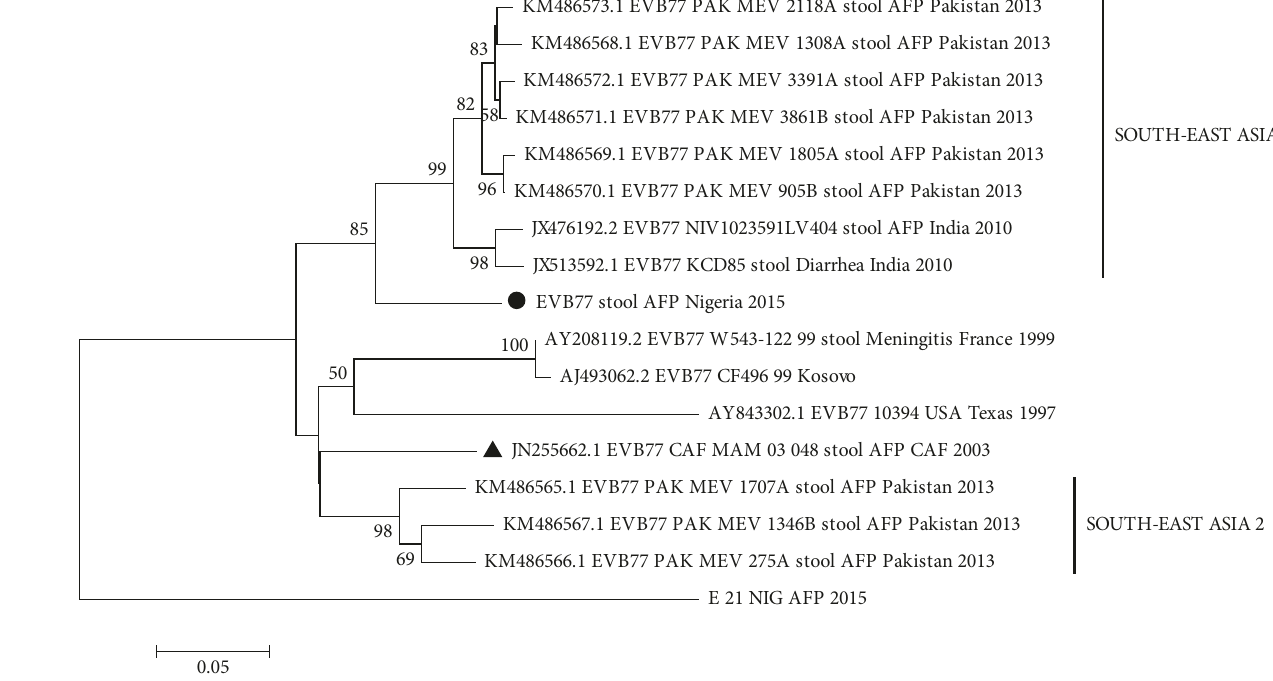
the suspension PCR screen comprising species B (58.3%) and species C (41.7%) (Table